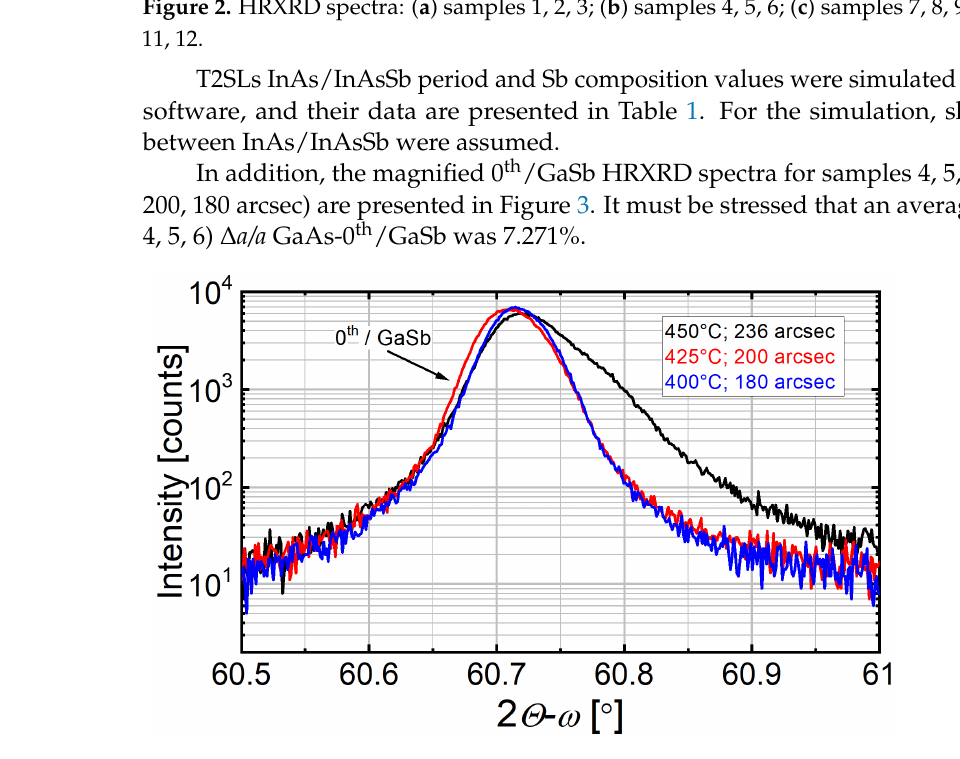
Figure 3. The magnified 0 th /GaSb HRXRD spectra for samples 4, 5, and 6 (FWHM 236, 200, 180